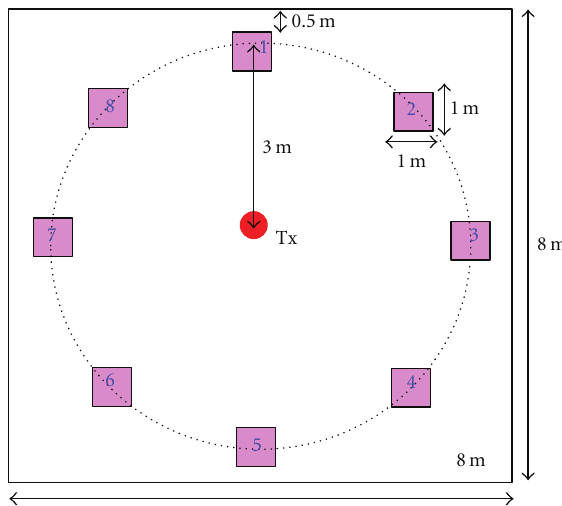
the same floor for the NLOS environment. There is a concrete wall with a thickness of 10 cm between the two